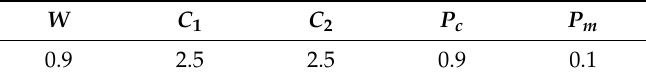
Table 5. The initial setting for parameters of MP-PSOGA.